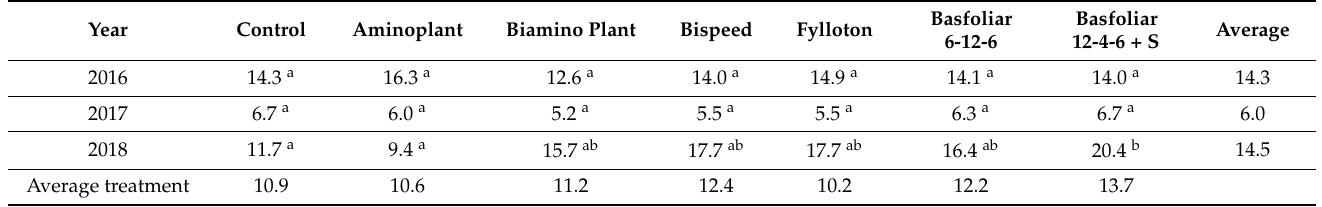
Table 4. The root number of M.9 rootstock stoolings depending on the tested treatments.